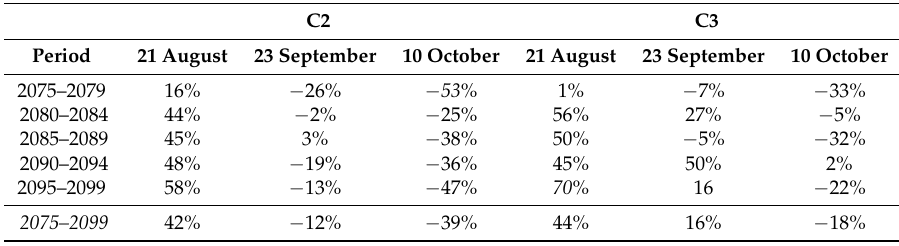
Table 4. Average change in percentage from simulated baseline for 5-year period at the End-of-Century for C2 and C3